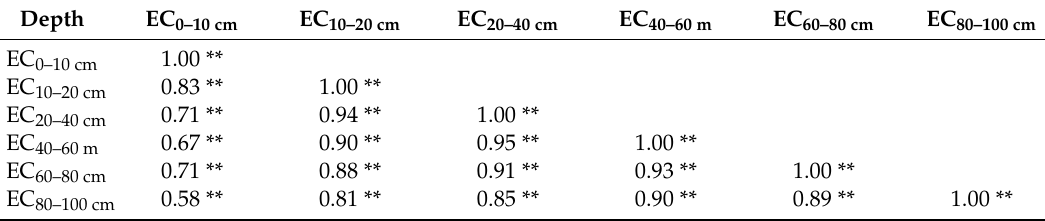
Table 3. Pearson’s correlation coefficient among soil salinity at different depths ( n = 132).